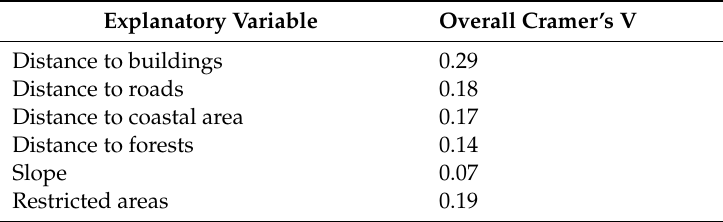
Table 5. Cramer’s power for external